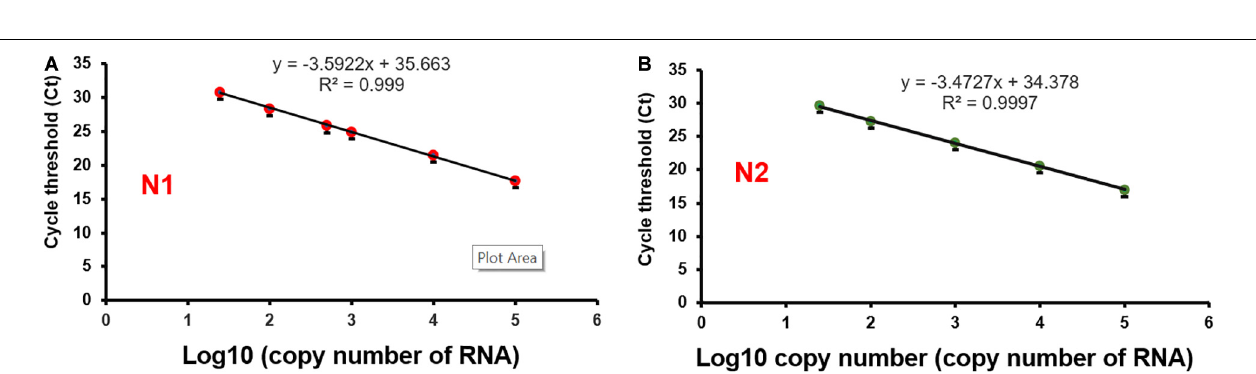
Frontiers in Microbiology |